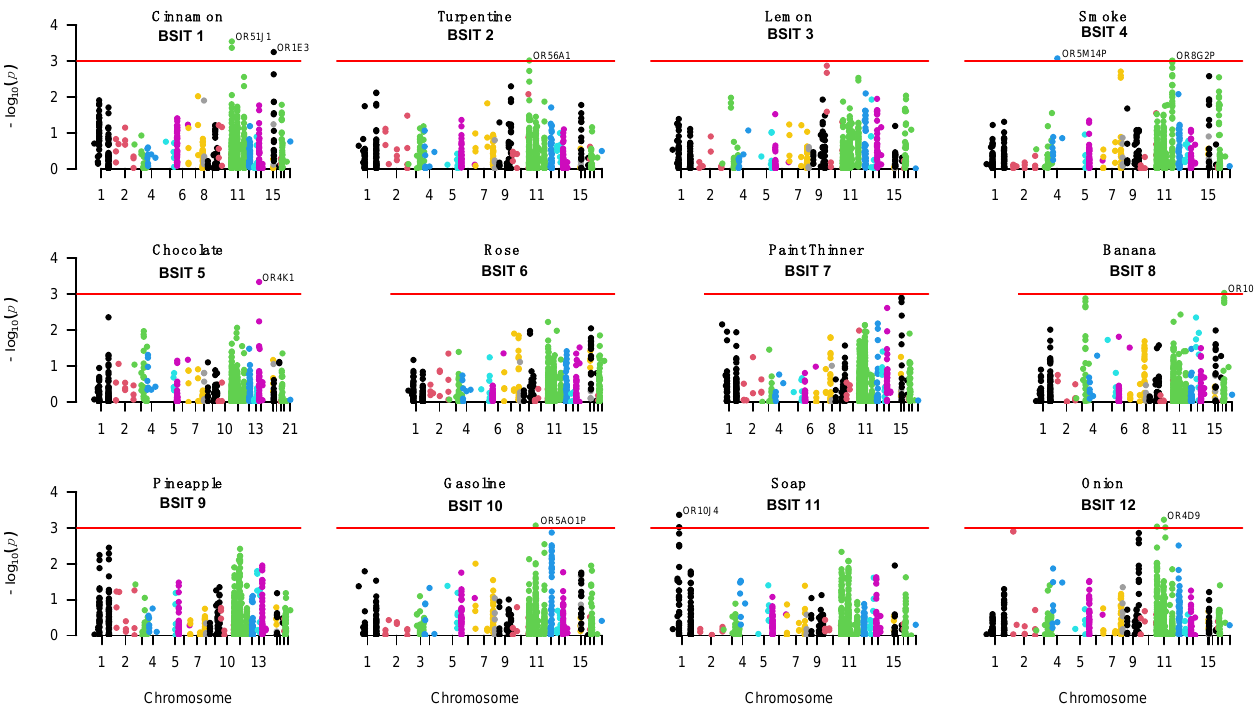
Figure 1. Manhattan plots of the olfactory gene-based association results for all 12 BSIT items. Genes with a p-value < 0.001 (red line) are named.